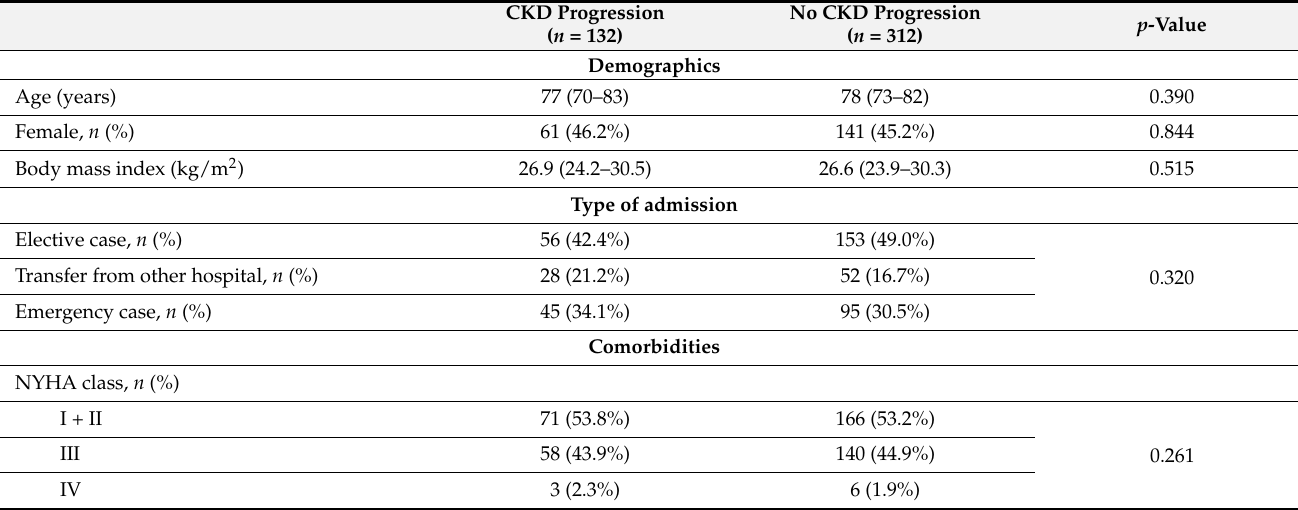
Table 3. Patient characteristics according to progression of chronic kidney